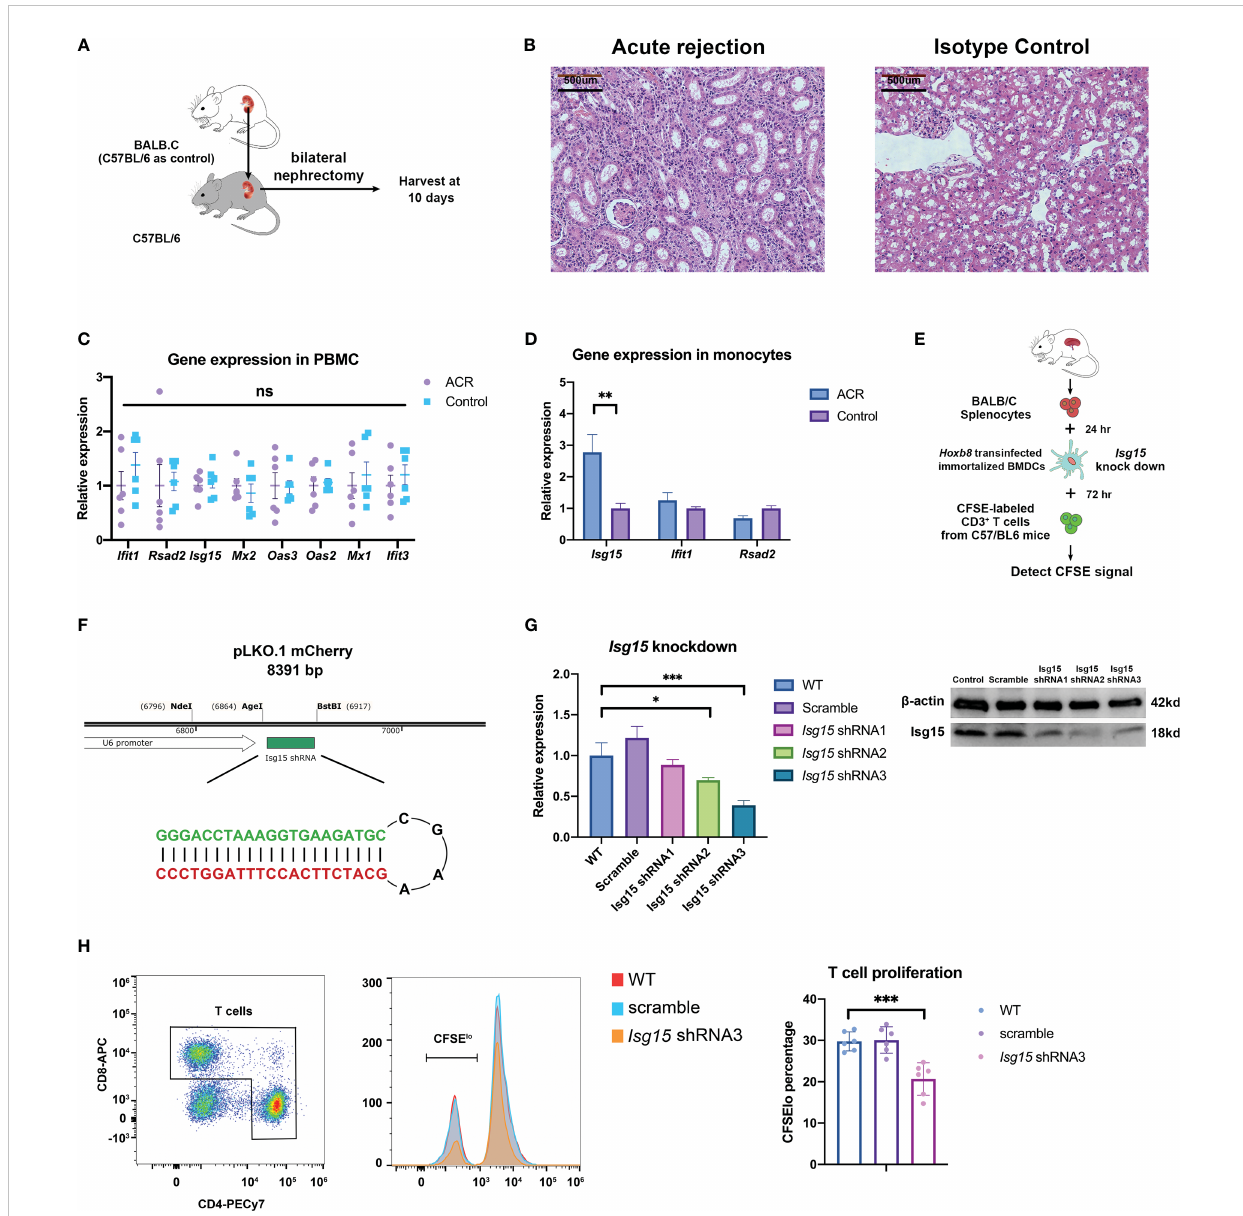
FIGURE 7 The kidney transplantation experiments verify the correctness and rationality of predicting transplant rejection through gene expression. (A) Schematic diagram of acute rejection model in mouse kidney transplantation. (B) Pathology of the acute rejection model versus the control group. (C) Expression of prediction genes in PBMC between acute rejection and control group. (D) Expression of prediction genes in peripheral monocytes isolated by FACS. (E) The fl owchart of the lymphocyte-stimulated assay. (F) Construction strategy for Isg15 gene knockdown by shRNA. (G) The knockdown ef fi ciency of Isg15 expression at transcription and translation level. (H) The CFSE signal and T cell proliferation in lymphocyte- stimulated assay. FACS, fl uorescence-activated cell sorting; CFSE, carboxy fl uorescein succinimidyl ester. "ns" means “ not signi fi cant ” . *p < 0.05; **p < 0.01; ***p <